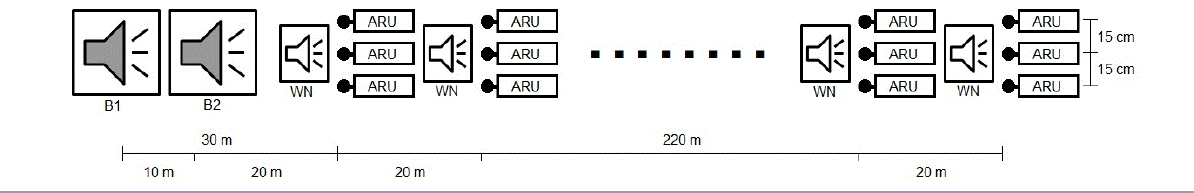
Fig. 1 . Schematic showing the experimental setup used to evaluate the effect of microphone sensitivity loss on detection of calls. The setup consisted of 12 triads (4 are pictured) of autonomous recording units (ARUs) arranged in a linear array spanning 220 m with individual triads spaced at 20-m intervals. Within each triad, ARUs were spaced 15 cm apart and equipped with one microphone from each of the three sensitivity classes. We simulated environmental noise caused by windy conditions by broadcasting white noise from speakers installed 1 m in front of each triad (WN) and broadcasted calls 20 m (B2) and 30 m (B1) in front of the first triad of